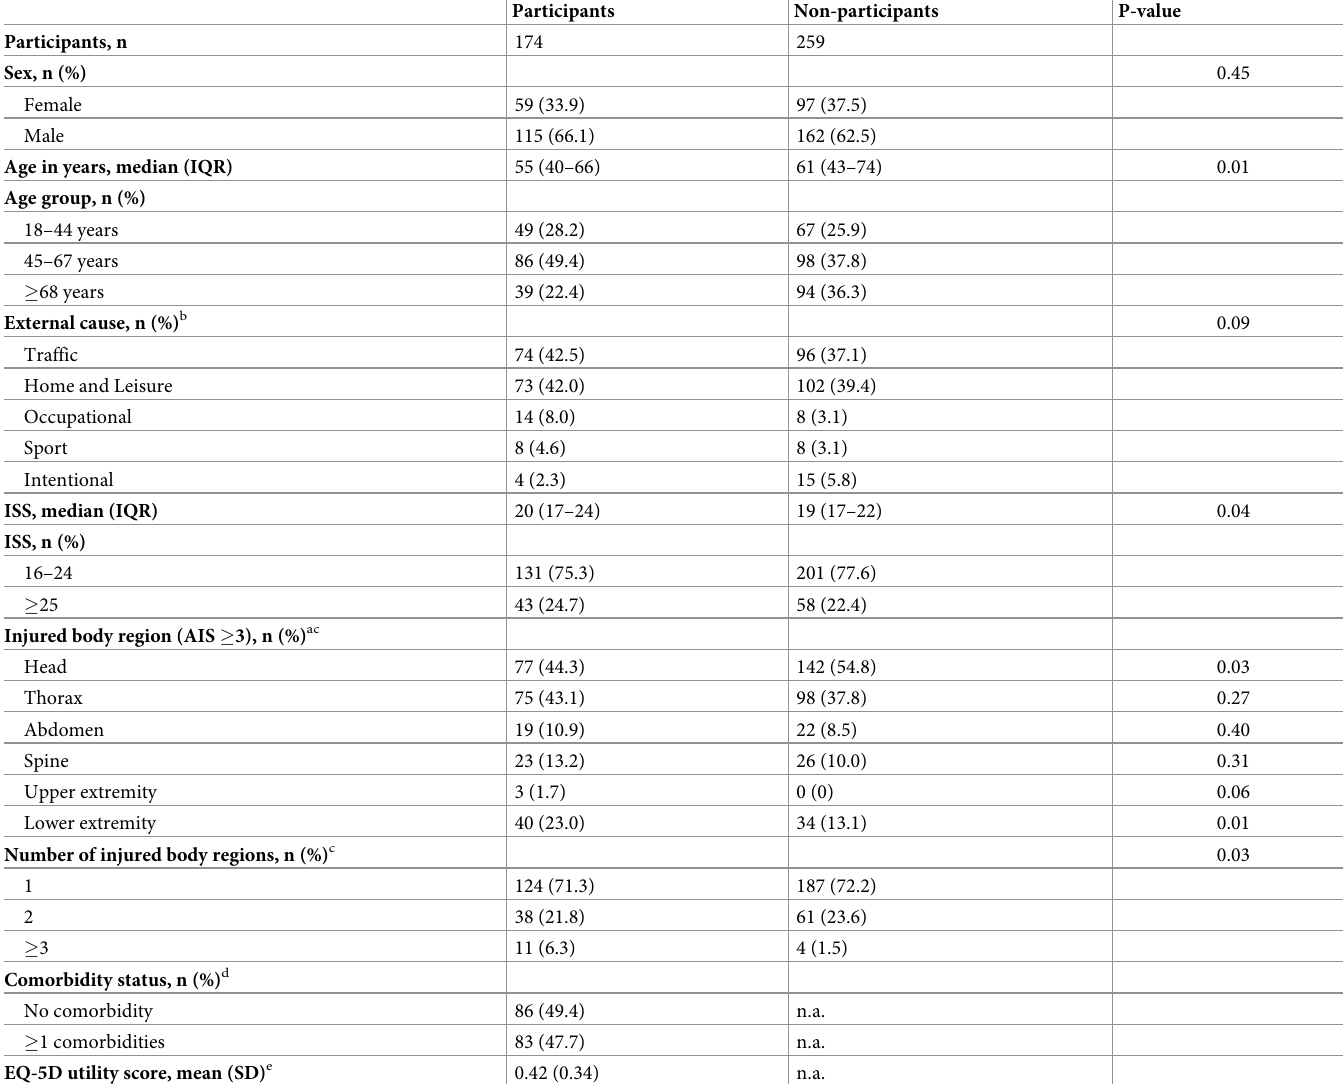
Table 1. Characteristics of the study population, by